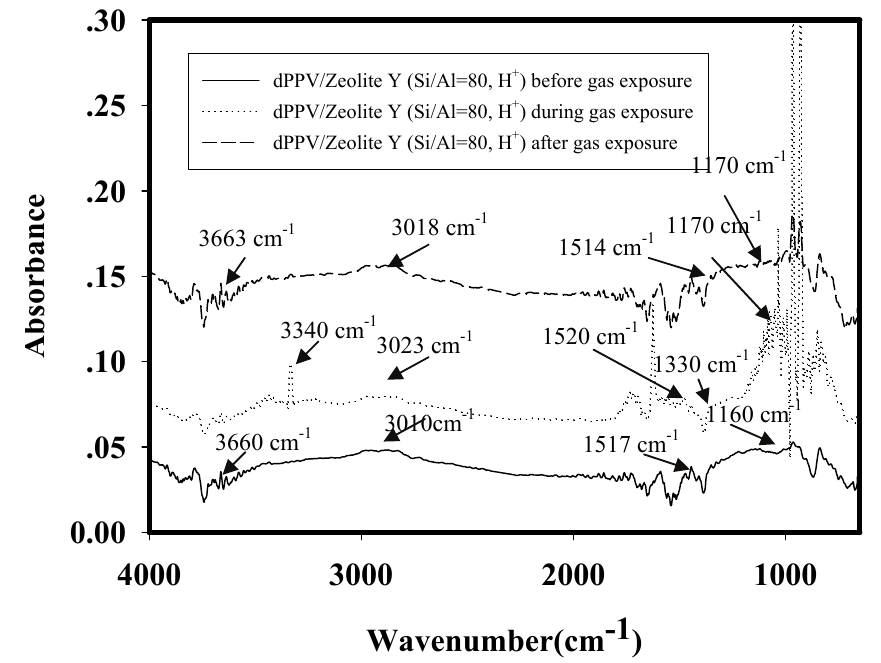
Figure 8. IR spectra of dPPV/zeolite Y (Si/Al = 80, H + ) exposed to NH (NH NO = 377 ppm, pressure at 1 atm and at T = 25 4 3